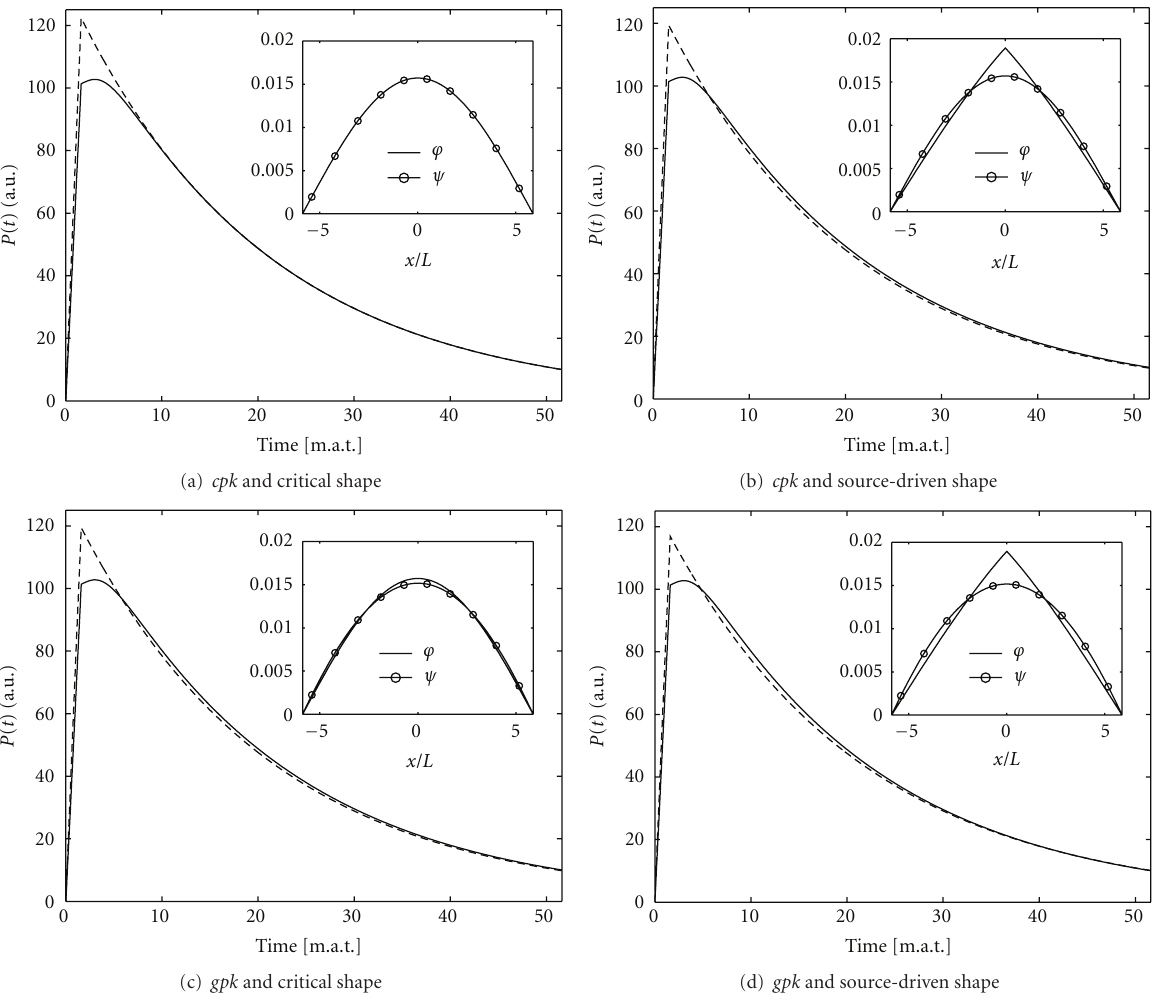
Figure 1: Power evolution following a source pulse in a subcritical system ( k e ff = 0 . 95), simulated with di ff erent approaches to point kinetics: cpk and gpk . Solid line: reference; dashed line: point kinetics. The inset graphs represent the shape ϕ and the weight ψ adopted (m.a.t.: mean absorption time = 1 / (v σ a